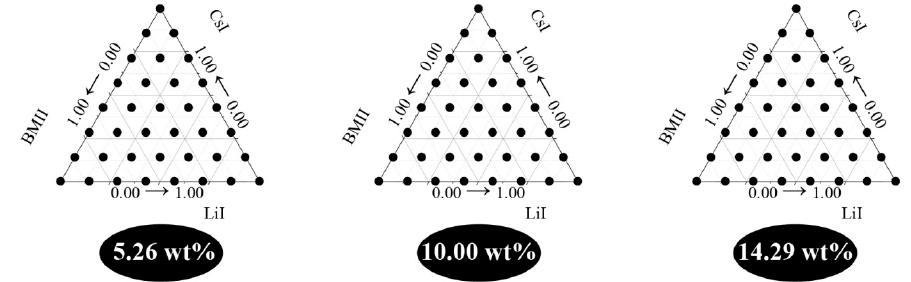
Figure 2. Design of experiment for the preparation of the PhCh–(LiI:CsI:BMII) GPE.